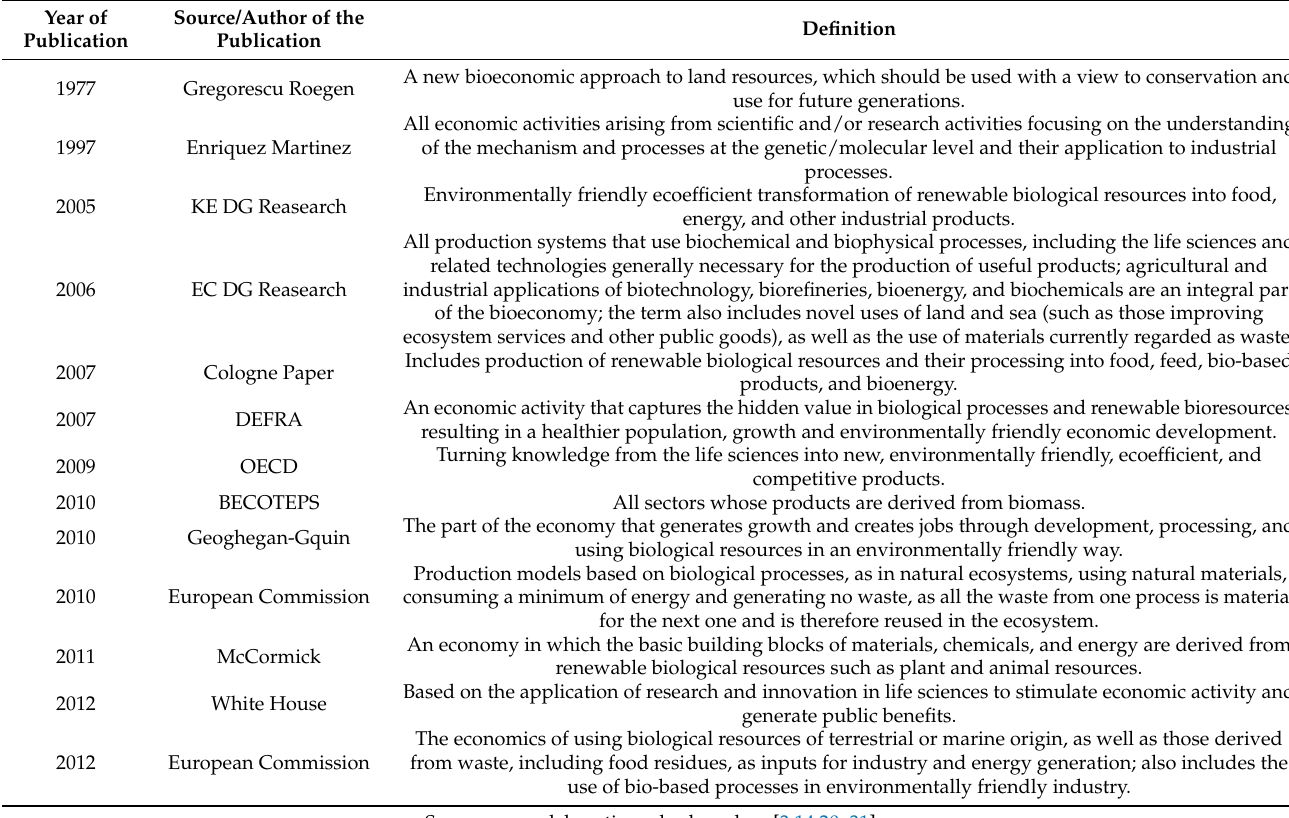
Table 1. Definitions of what constitutes the